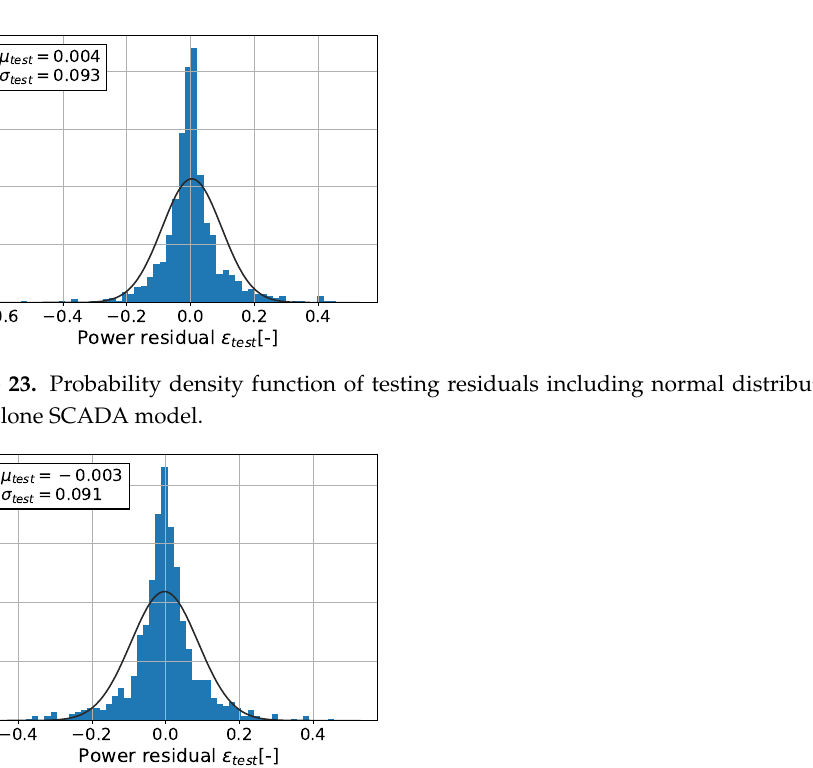
Figure 24. Probability density function of testing residuals including normal distribution fit for transfer learning model.